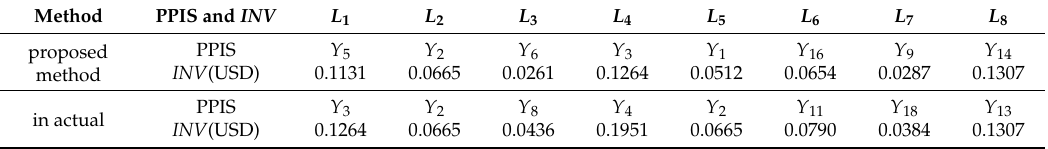
Table 6. Matching results and INV comparison for the proposed method and the